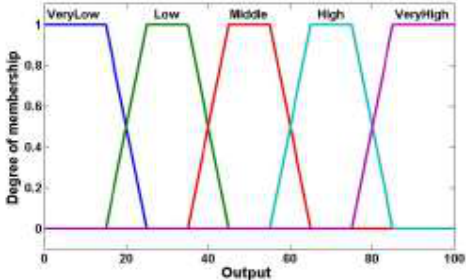
Figure 10. Membership functions of the fuzzy system output.